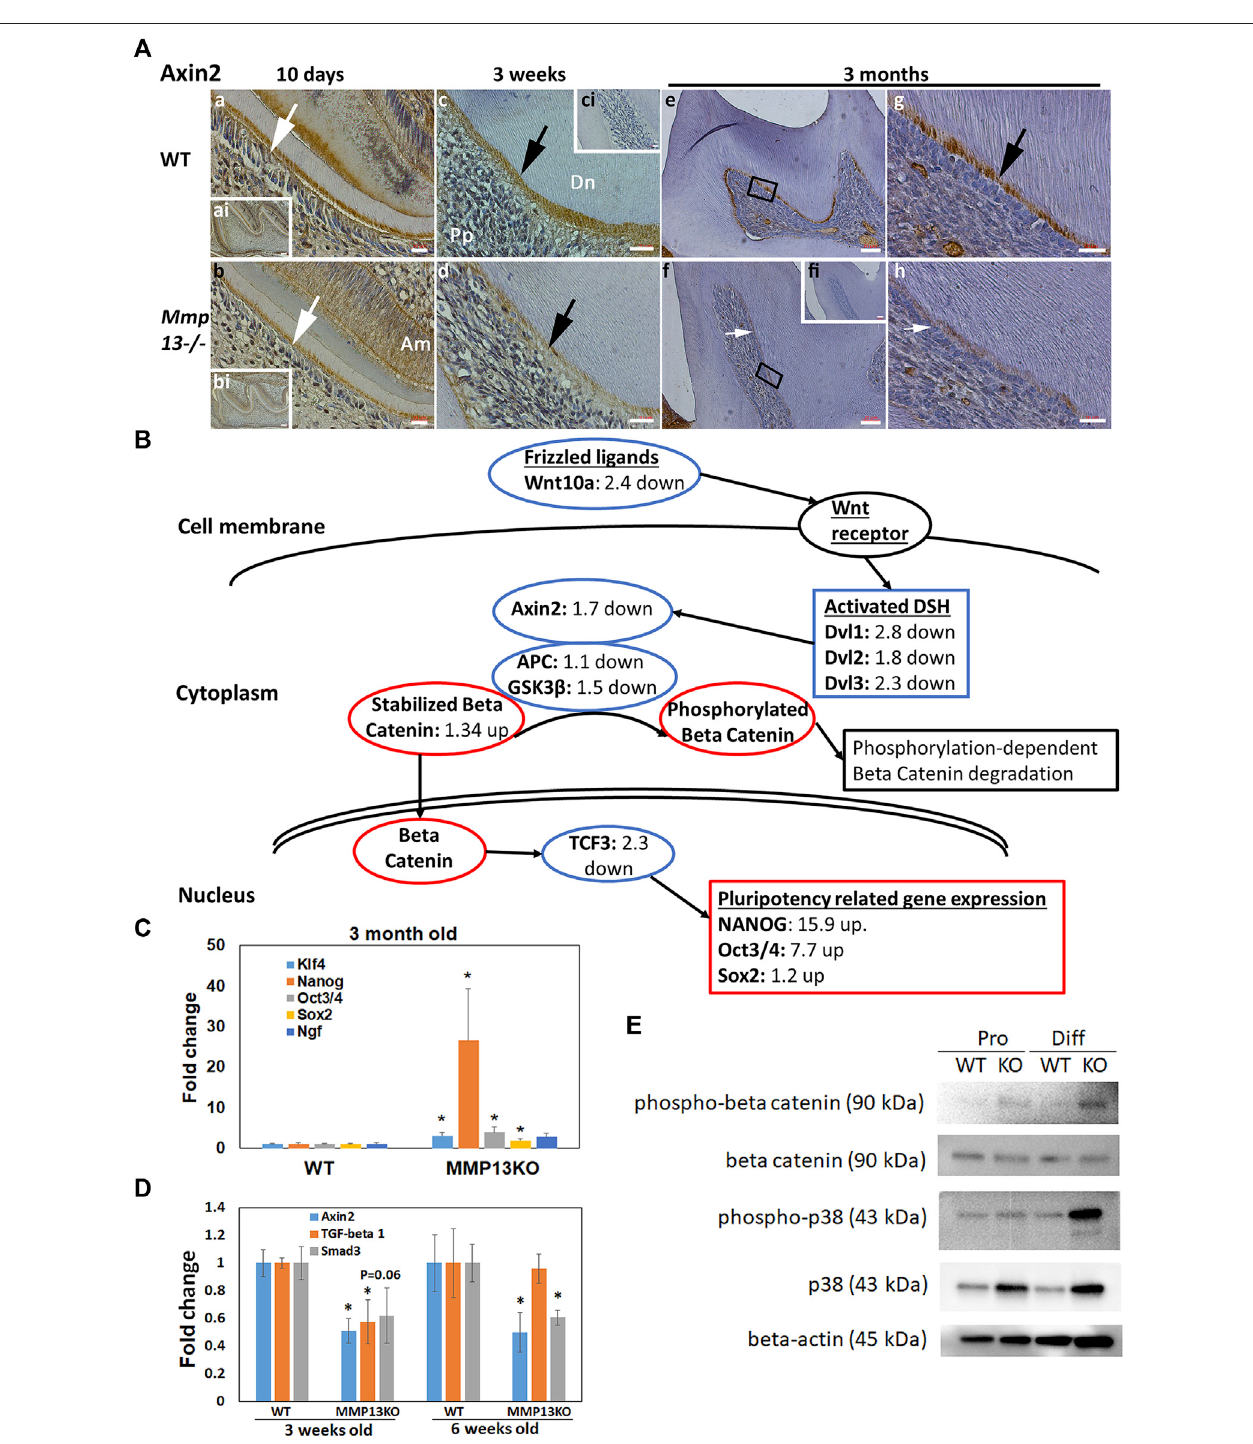
FIGURE 7 | Wnt responsive gene Axin2 expression is reduced in Mmp13 − / − odontoblasts, while Nanog is increased and the Wnt signaling pathway suppressed after MMP13-loss. (A) IHC-Axin2 expression is decreased in the odontoblast and predentin layer of developing (10-day [ (a, b) — white arrow], 3-week [ (c, d) — black arrow]),andmature fi rstmolars(3-month[ (e – h) white,blackarrow])of Mmp13 − / − samplescomparedwithWTsamples. (ci) representsanunstainedcontrolofthesame cusp as (c) ,while (g, h) are higher magni fi cations ofthe indicatedarea identi fi ed in (e, f) , respectively. (a, b) represent higher magni fi cations ofthe indicated area in the (ai, bi) , respectively. Scale bars = (ai, bi, ci, e,f) 20 μ m (original mag. ×20), (a – d) 10 μ m (original mag. ×40), and (g, h) 5 μ m (original mag. ×63). Abbreviations: Am, ameloblast; Dn, dentin; Pp, pulp. Sections were examined from fi ve mice at 3-day, six mice at 10-day postnatal, and nine mice at 3 months for both genotypes. (B)